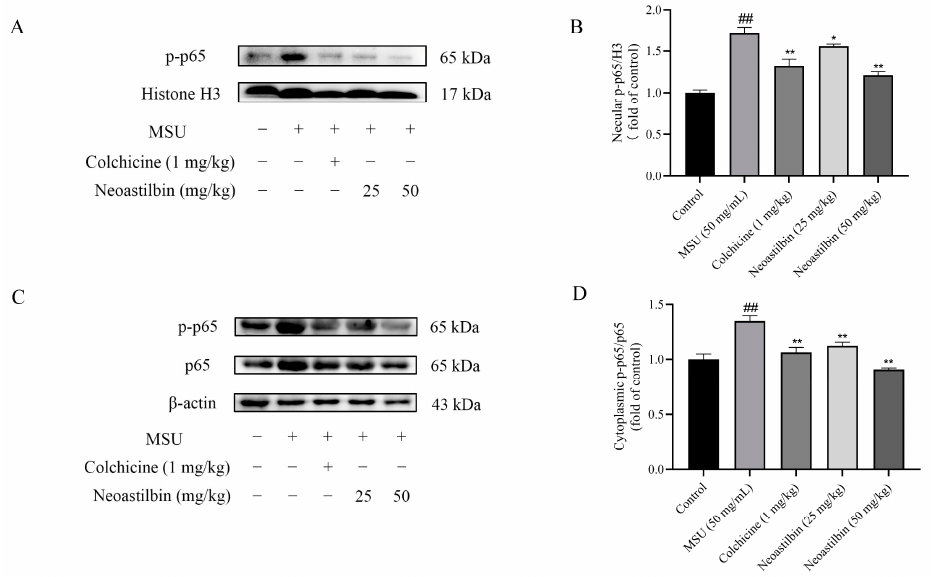
Figure 10. Effects of neoastilbin on protein expression of NF- κ B p-p65 in GA mice. ( A ) The protein expression of p-p65 in the nucleus. ( B ) The ratio of protein expression of p-p65/H3 in the nucleus. ( C ) Phosphorylated and non-phosphorylated expressions of p65 in the cytoplasm. ( D ) The ratio of protein expression of p-p65/p65 in the cytoplasm. Data in the figures represent the means ± SD; significant differences among different groups are indicated as ## p < 0.01 vs. control group, * p < 0.05, ** p < 0.01 vs. MSU group ( n = 3).